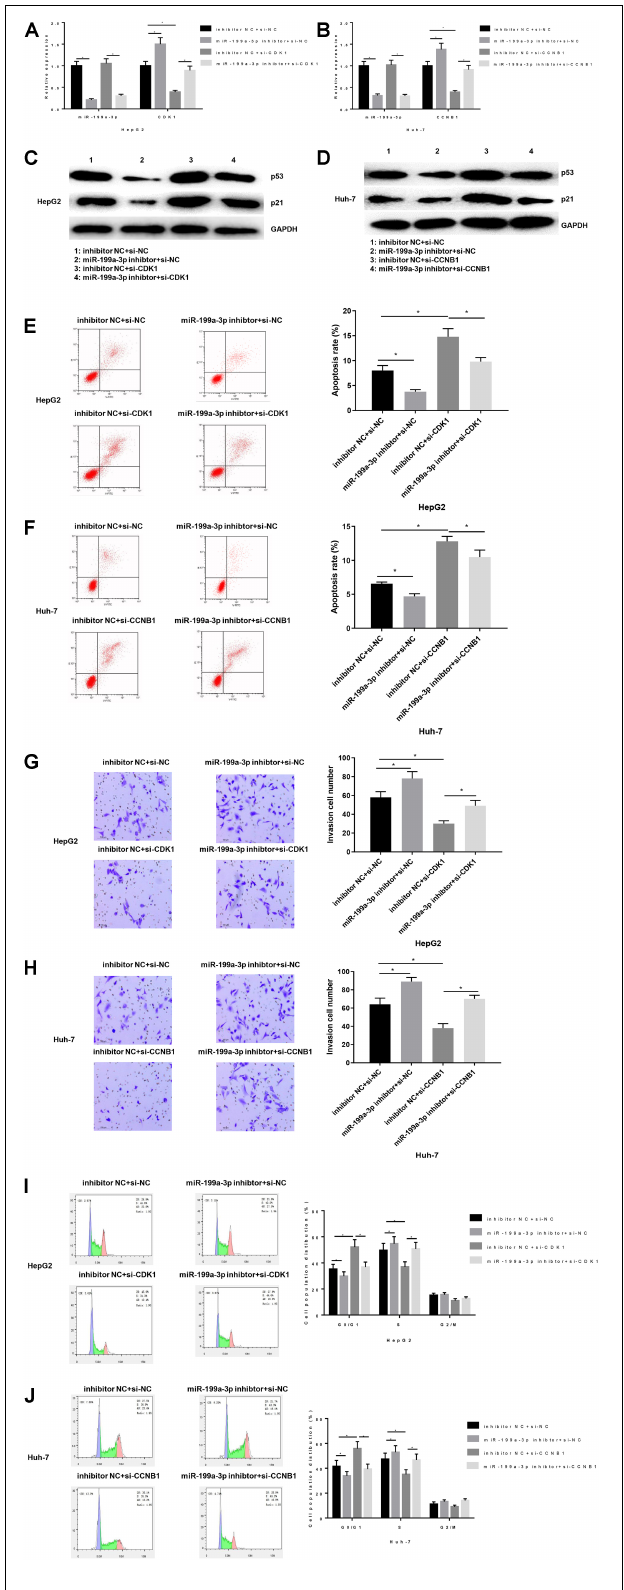
FIGURE 5 | miR-199a-3p affects the apoptosis, invasion and cell cycle of HCC through CDK1 and CCNB1. The mRNA and protein expressions of miR-199a-3p, CNK1, CCNB1, p53 and p21 in each group were detected by qRT-PCR and WB, respectively. Cells development in each group was detected by FCM and Transwell assays (100 × ). (A) MRNA expressions of miR-199a-3p and CDK1 in HepG2 cells; (B) MRNA expressions of miR-199a-3p and CCNB1 in Huh-7 cells; (C) The protein expressions of p53 and p21 in HepG2 cells; (D) The protein expressions of p53 and p21 in Huh-7 cells; (E,F) Cell apoptosis; (G,H) Cell invasion; (I,J) Cell cycle. *represents P < 0.05. Representative of three independent experiments.